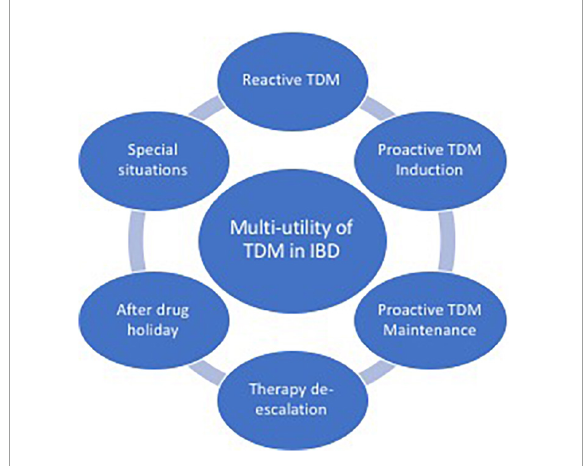
FIGURE1 Aspects of multi-utility of therapeutic drug monitoring (TDM) in inflammatory bowel disease